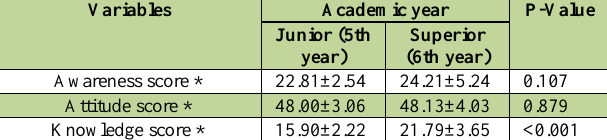
Table 2: Determination of levels of awareness, attitude, and knowledge among dentistry students concerning EBD based on the academic year. Variables